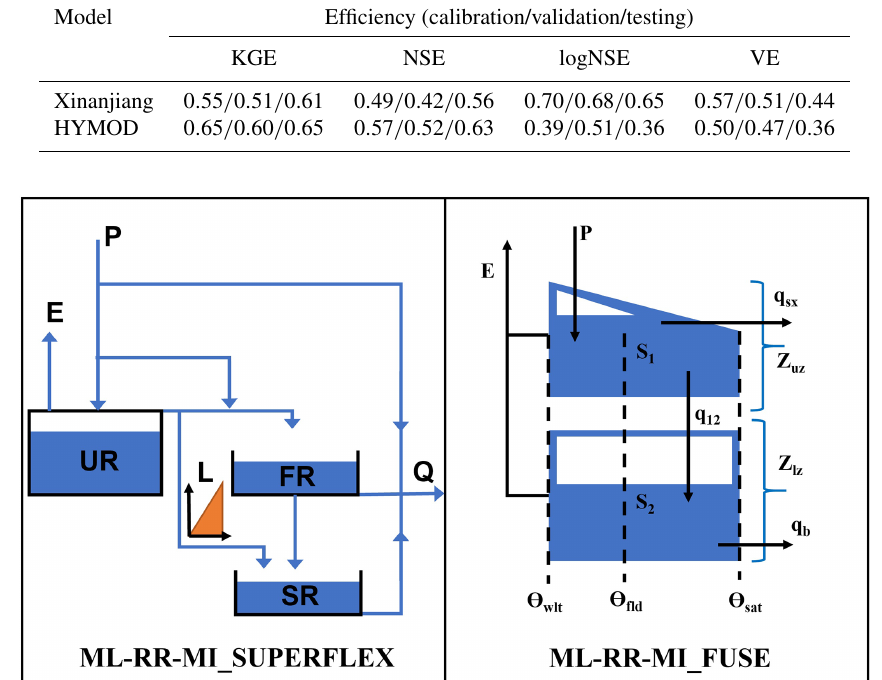
Figure 11. ML-RR-MI_SUPERFLEX and ML-RR-MI_FUSE model configurations ( P – precipitation; E – evaporation; Q – total discharge; SR – slow-reacting reservoir; FR – fast-reacting reservoir; UR – unsaturated reservoir; L – half-triangular lag function; q b – base flow; q s x – surface flow; q 12 – percolation; Z u z and Z l z – depth of unsaturated zone and saturated zone; S 1 and S 2 – unsaturated zone and saturated zone water content; (cid:50) wlt , (cid:50) fld , and (cid:50) sat – soil moisture at wilting point, field capacity, and